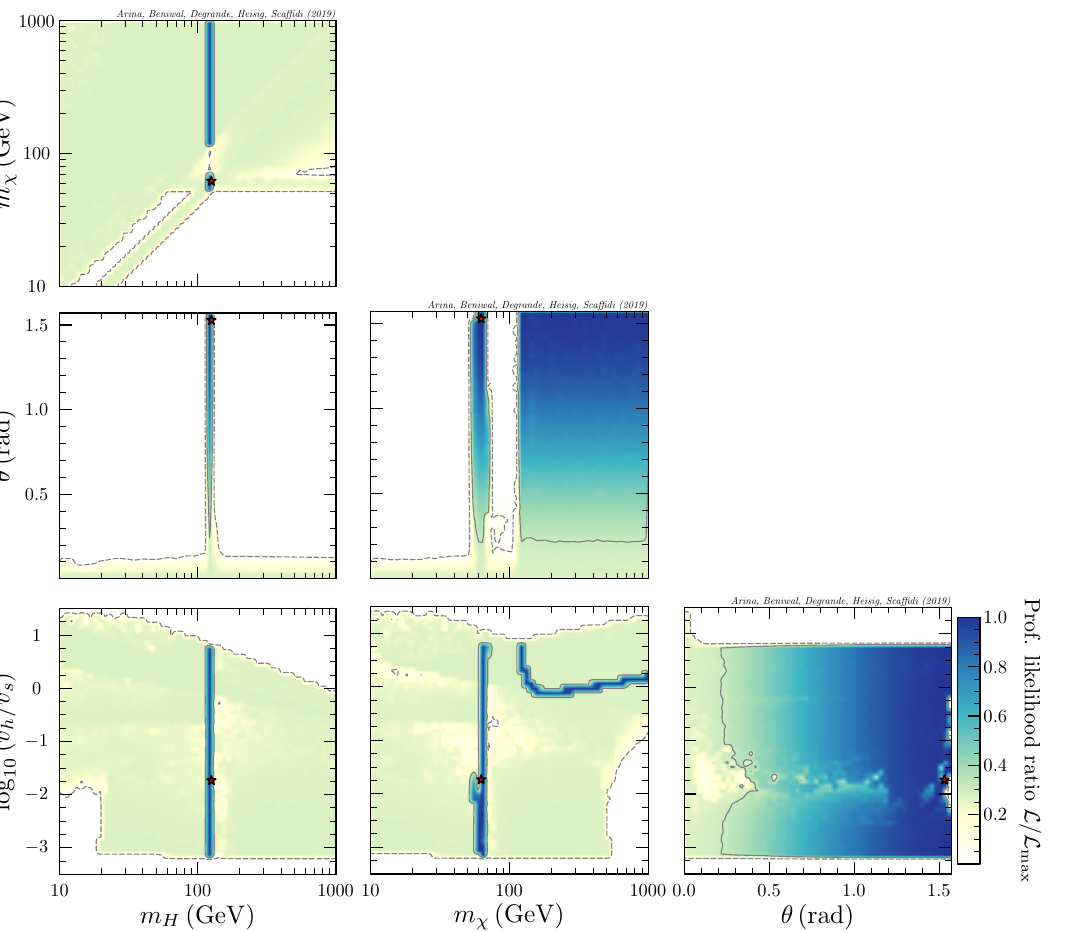
Figure 1 . 2D pro(cid:12)le likelihood ratio (PLR) plots in the planes of pNG DM model parameters. The 1 (cid:27) (2 (cid:27) ) CL regions are marked by solid (dashed) lines. The best-(cid:12)t point is marked by a red star; it is also summarised in column 1 of table